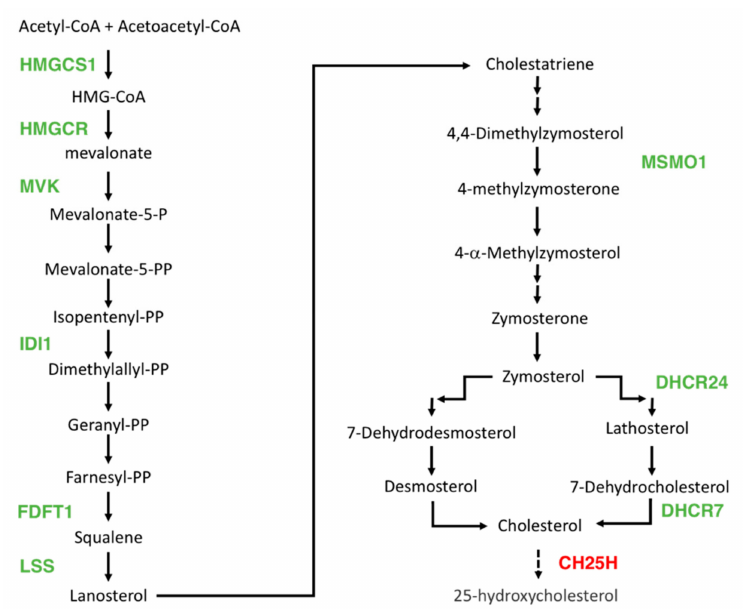
Figure 5. Schematic view of genes downregulated (green) and upregulated (red) in the biosynthesis and degradation pathway of